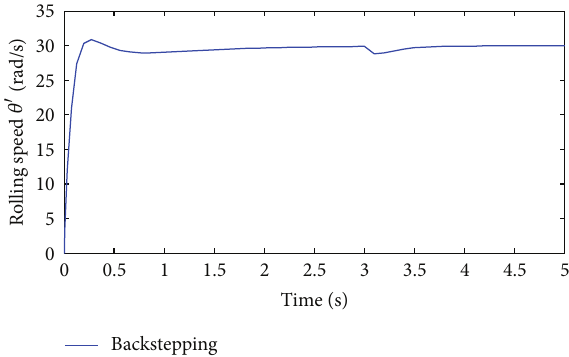
Figure 4: Step response of rolling speed under load